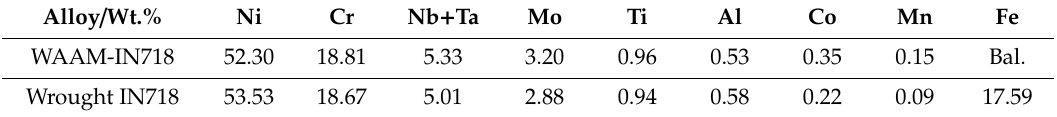
Table 1. Chemical compositions (wt.%) of WAAM and reference wrought IN718 alloy. Alloy / Wt.% Table 1. Che mical compositions (wt.%) of WAAM and reference wrought IN718 alloy.